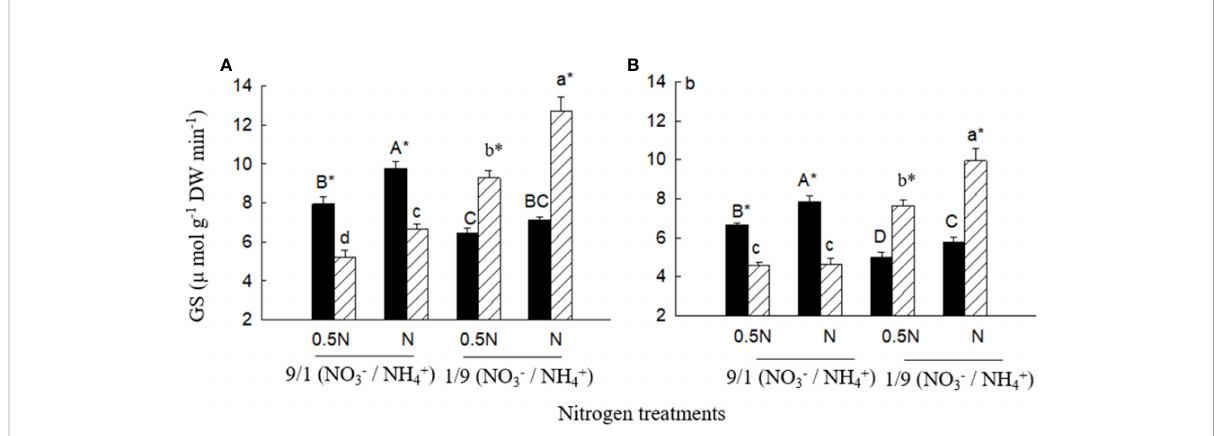
FIGURE 8 Glutamine synthetase (GS) activities in leaves (A) and roots (B) of Xanthium sibiricum (striped bars) and X. strumarium (closed bars) in different nitrogen treatments. 0.5 N and 1 N indicate 50% and 100% nitrogen concentration of the Hoagland nutrient solution, respectively. Means + SE ( n = 6). Different upper- and lowercase letters indicate signi fi cant dfferences among nitrogen treatments for X. strumarium and X. sibiricum , respectively ( P < 0.05; one-way ANOVAs); * indicates signi fi cant difference between the invasive and native species in the same treatment ( P < 0.05; independent sample t